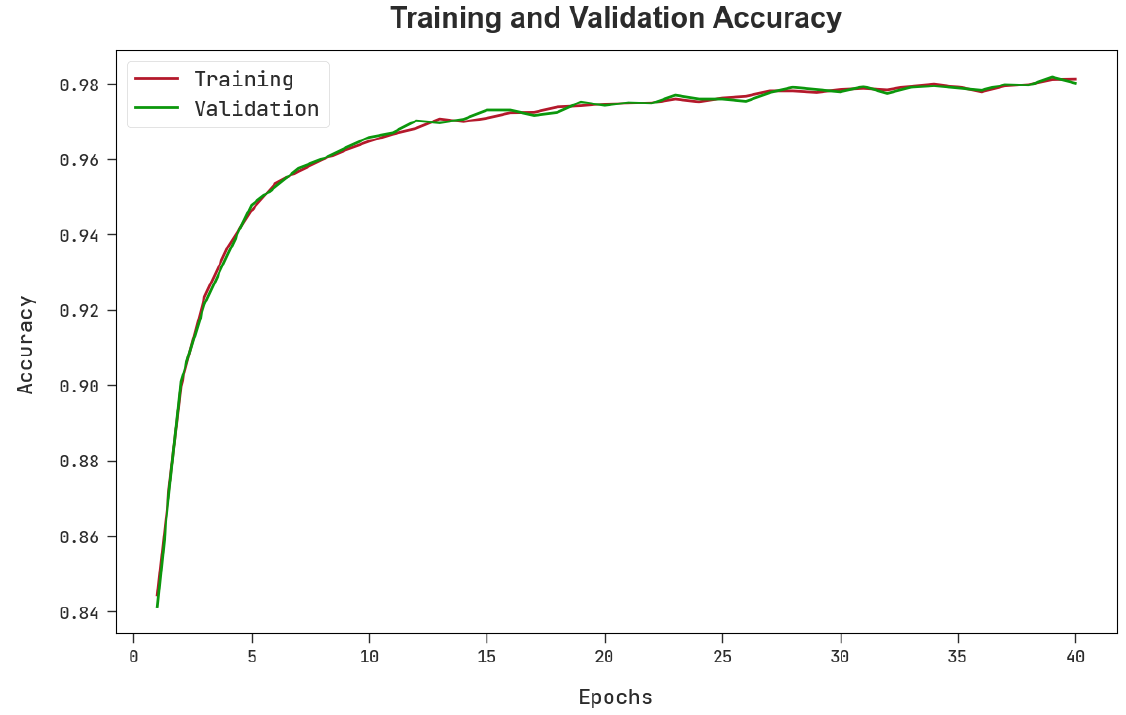
Figure 9. TACY and VACY outcomes of the MPADL-LC3 algorithm. The TLOS and VLOS of the MPADL-LC3 technique are tested on colon and lung cancer classification performance in Figure 10. The figure implied that the MPADL-LC3 model exposed superior performance with minimum values of TLOS and VLOS. Particularly, the MPADL-LC3 approach has the fewest VLOS